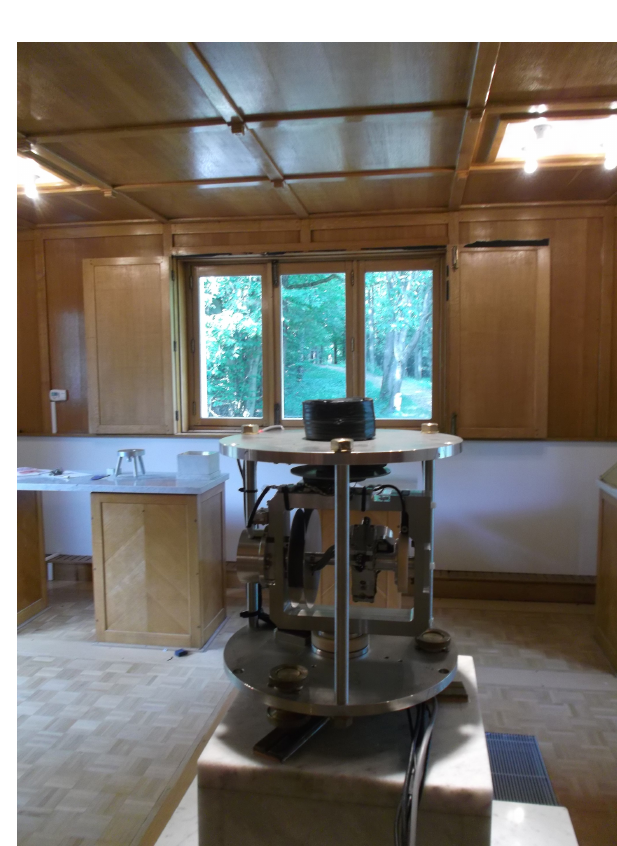
Figure 4. AutoDIF mk2.2 on pillar DO2 in Dourbes absolute